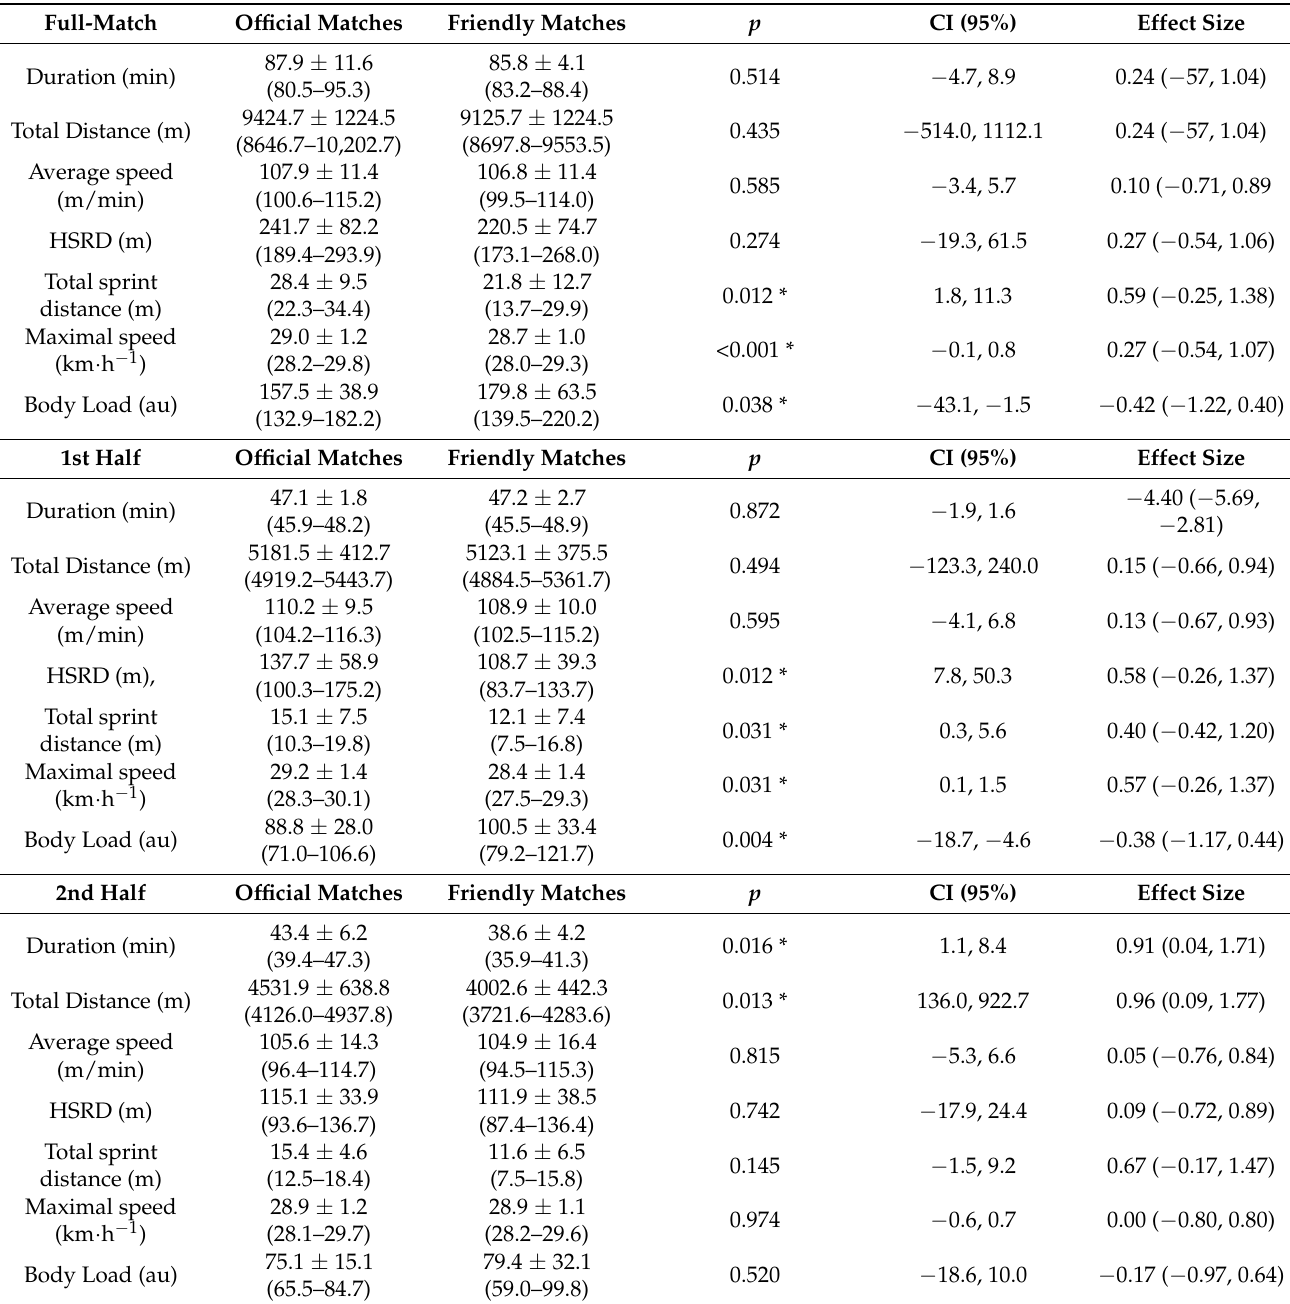
Table 2. Comparison of full match-day, 1st and 2nd halves between official matches and friendly matches, mean ± standard deviation and CI